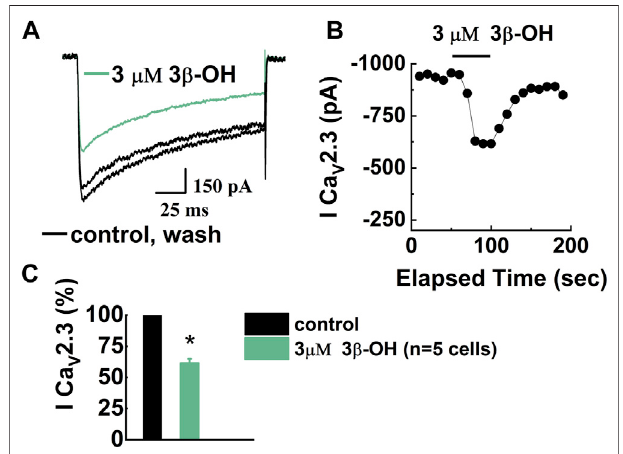
FIGURE1| InhibitionofrecombinantCa V 2.3 R-typecurrentinHEKcells after bath application of 3 β -OH. (A) Representative barium currents in control conditionsbeforedrugapplication(black),duringtheperfusionof3 μ M3 β -OH (green), and after drug washout (black). (B) Graph shows time course of reversible Ca V 2.3 current amplitude reduction during the application of 3 β - OH. (C) Bar graph shows the percentage of R-type current reduction during the perfusion of 3 β -OH, which was averaged from multiple cells ( n = 5, paired two-tailed t -test, p < 0.05).